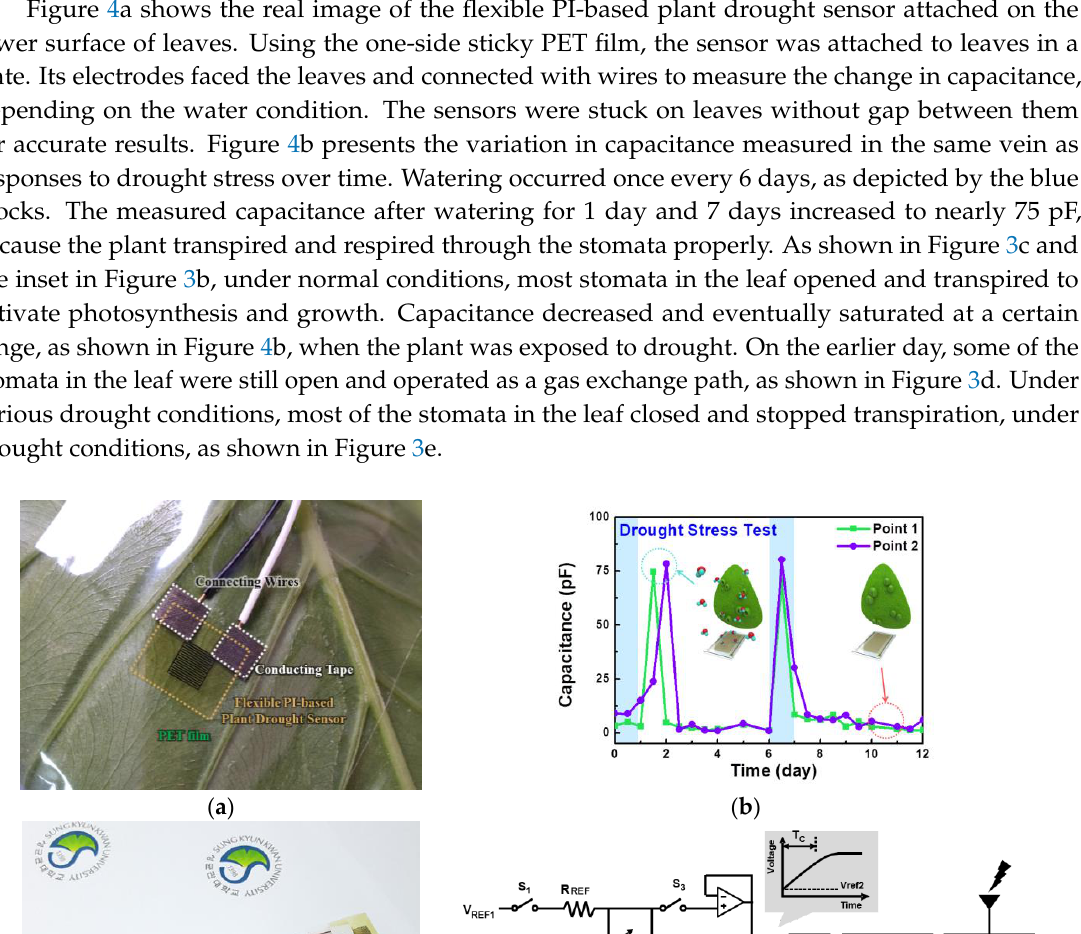
Figure 3. ( a ) Capacitance characteristics depending on stoma size; ( b ) time-varying changes in capacitance and pore size with watering once every 6 days. Watering is depicted as blue blocks; ( c – e ) optical images of a stoma in Nicotiana tabacum after watering for 1, 2, and 4 days.